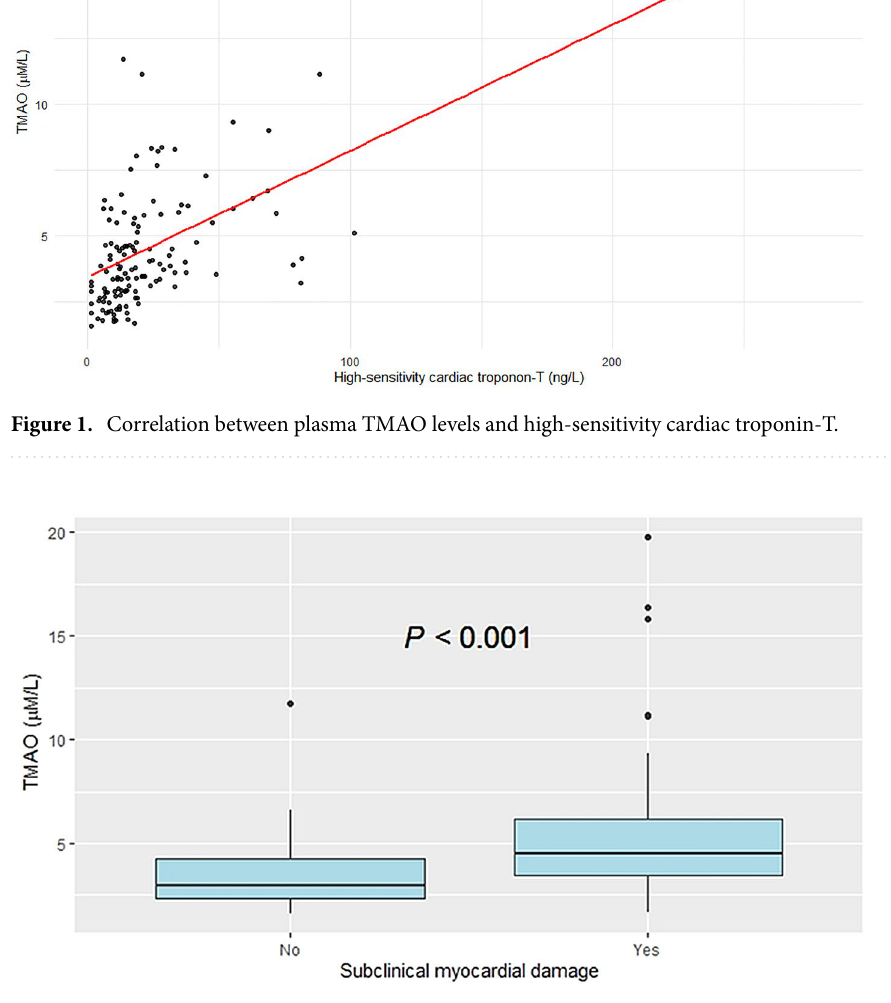
Figure 2. Relationship between plasma TMAO levels and subclinical myocardial